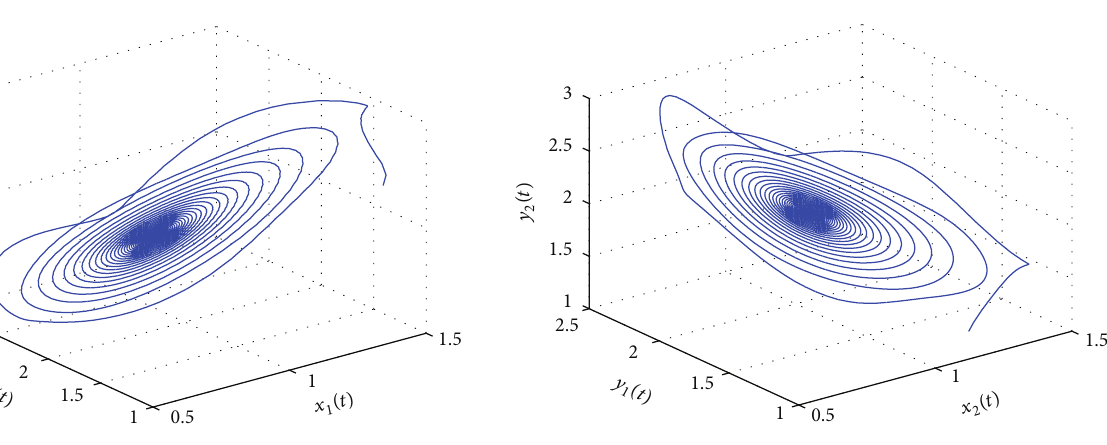
Figure 9: The phase plot of the states 𝑥 2 , 𝑦 1 , 𝑦 2 for 𝜏 2 = 7.7500 < = 9.9183 𝜏 20